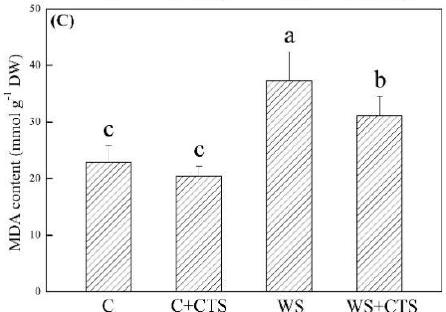
Figure 4. Seeds priming with chitosan affected ( A ) superoxide anion (O 2 − ) content, ( B ) hydrogen